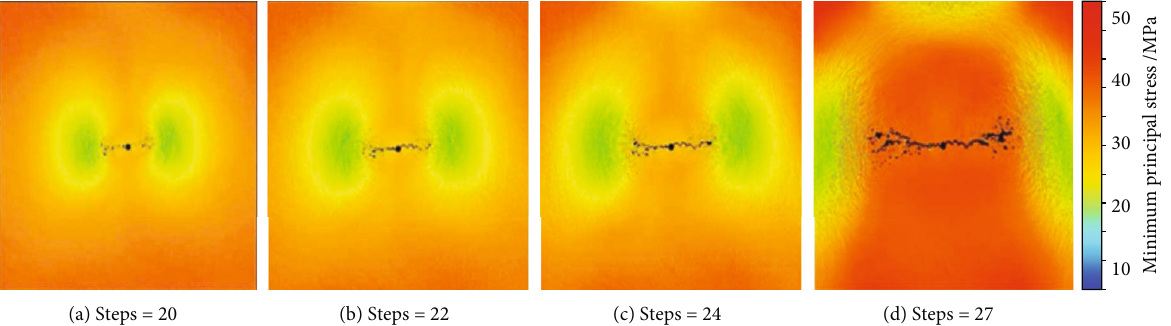
Figure 7: Hydraulic fracturing process without structural plane